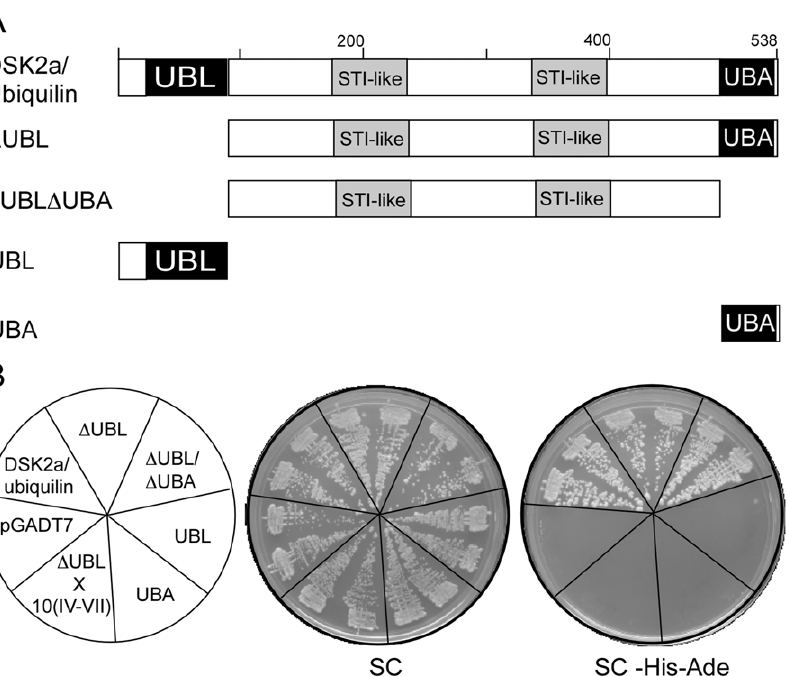
Figure 8. Interaction of DSK2a/ubiquilin with ATL10. (A) Schematic representation of DSK2a/ubiquilin showing UBL, UBA, and STI-like domains and derivative clones generated for the yeast two-hybrid assays; D UBL represents a clone obtained from the yeast two-hybrid screening. DSK2a/ ubiquilin-containing fragments were ligated into the activation domain of pGADT7. (B) Representative plates showing yeast two-hybrid interactions between DSK2a/ubiquilin derivative clones and ATL10(I); the left panel shows the template of the plates. The yeast strain AH109 was cotransformed with pGBKT7 and pGADT7 derivatives, selecting for transformants on SC lacking Trp and Leu. Transformants were then streaked onto SC medium lacking Trp and Leu (SC) and onto SC medium lacking Trp, Leu, His and Ade (high-stringency selective conditions). The plates were incubated at 30 u C for four days; growth is seen as dense streaks of yeast over background. The interaction of ATL10(IV–VII), a clone lacking region (I), with D UBL was also included as a negative control.